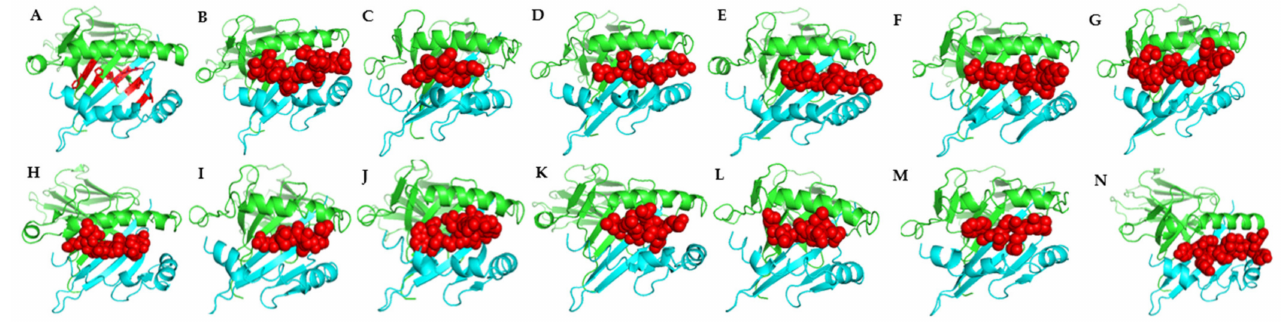
Figure 9. Interactions between Atlantic salmon MHC class II complex and the common